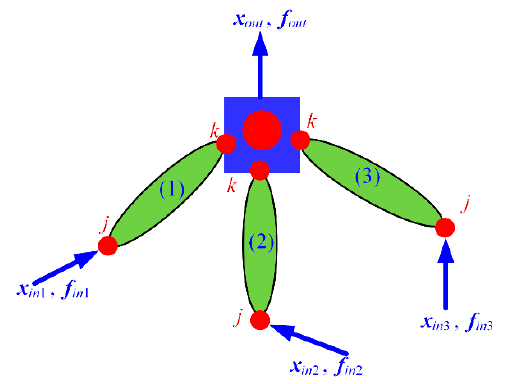
Figure 7. The equivalent topology of typical compliant mechanisms.